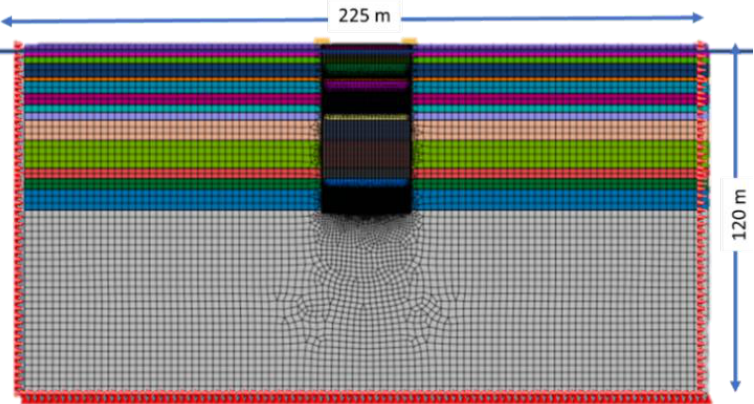
Figure 7. Two-dimensional plane strain finite element model.